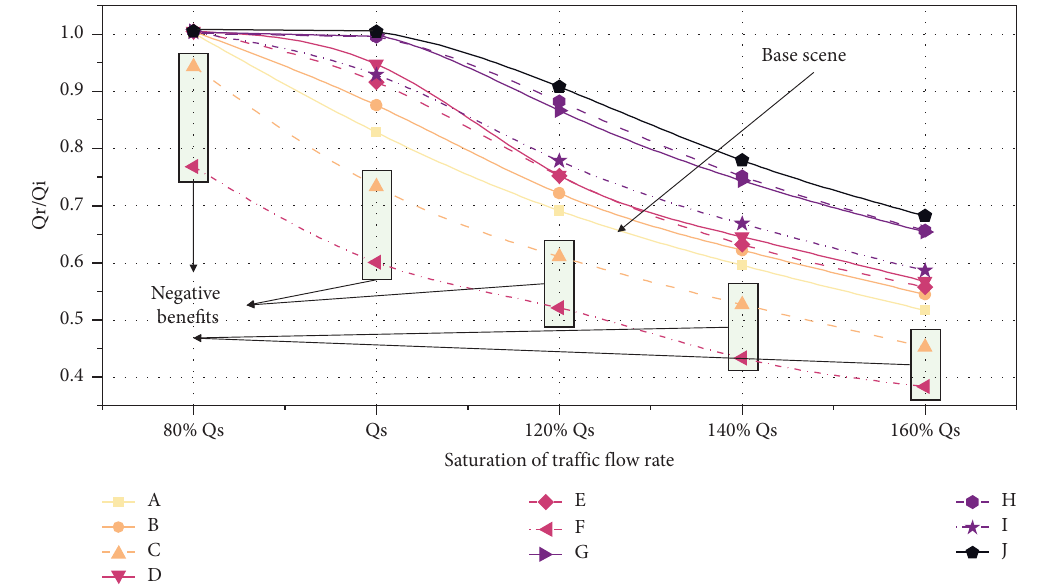
Figure 4: Actual road capacity in diferent scenes under diferent trafc conditions. Table 4: Te value of the actual road capacity and its variation from scene A.